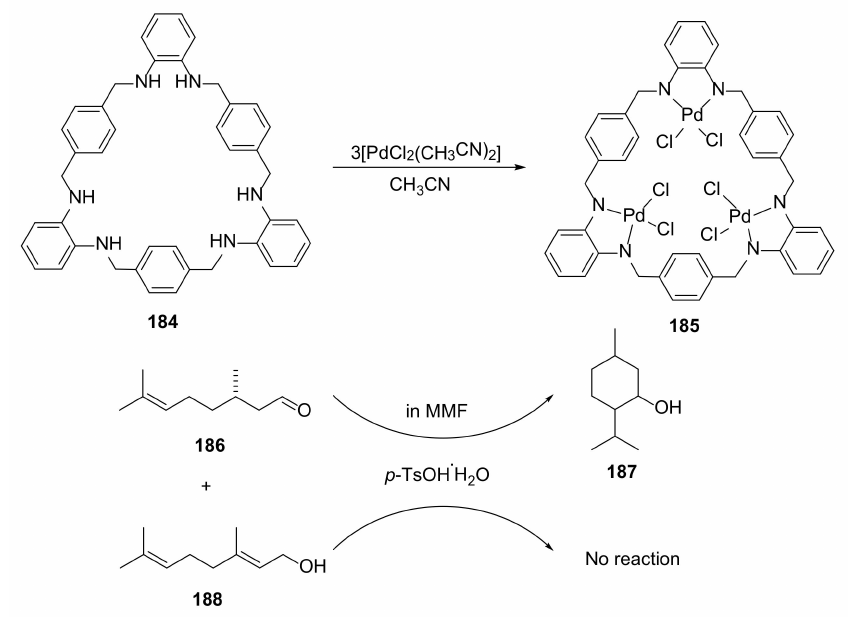
Figure 39. Synthesis of macrocycle 185 for the metal–macrocycle framework to catalyze specific heterogeneous cyclization reaction.